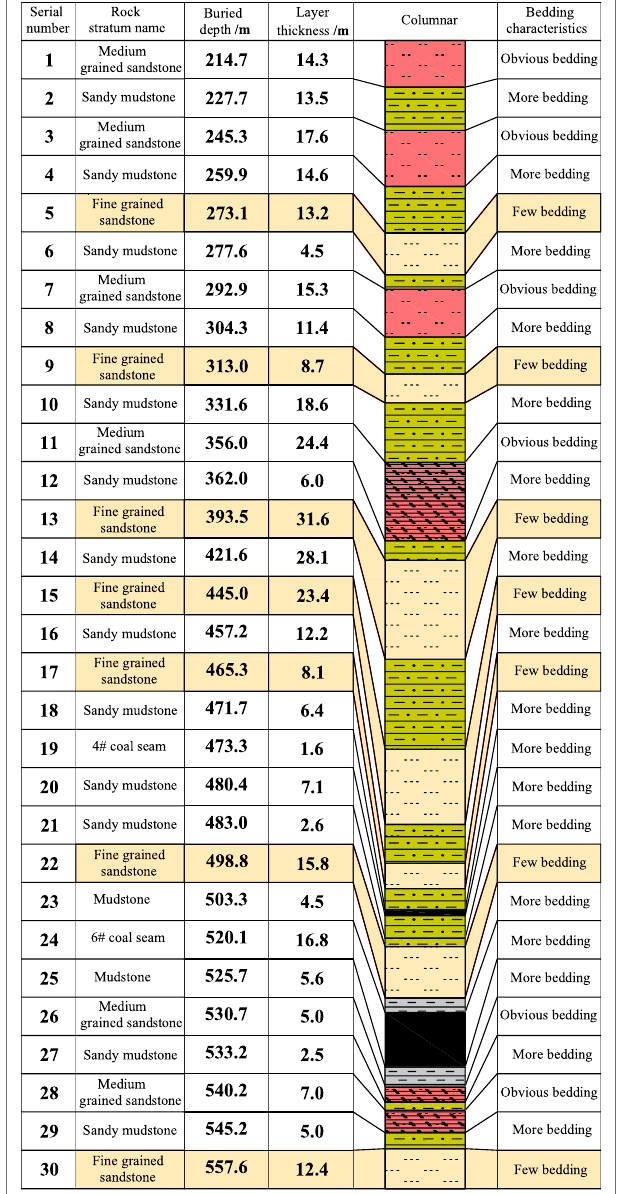
FIGURE 1 | Coal stratum histogram of the working face.